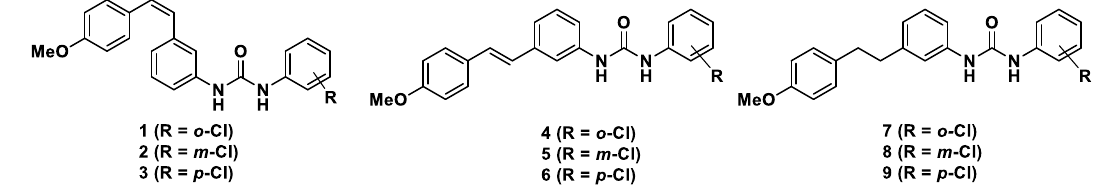
chose chlorophenyl Ureas 1–9 for a preliminary evaluation indicated in Figure 3 [20].